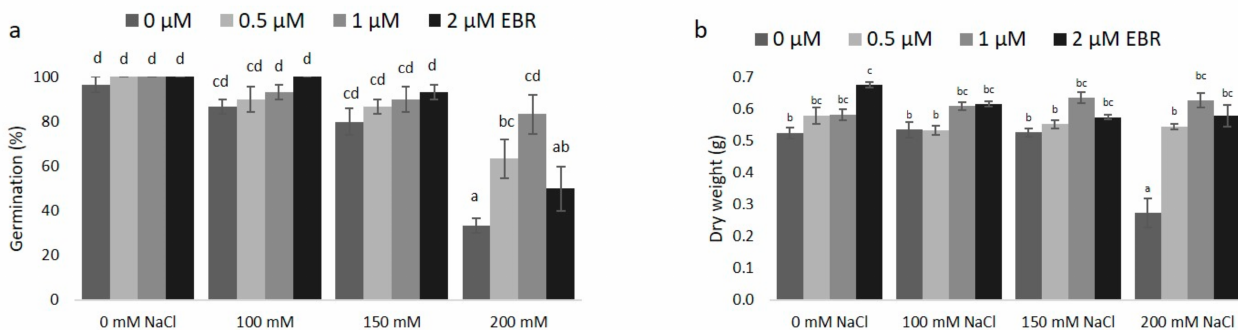
Figure 1. Cotton seed germination and seedling growth under salt stress following pre-treatment with 24-epibrassinolide (EBR). Percent germination ( a ) and seedling dry weight ( b ) in response to 0, 0.5, 1 and 2 µ M concentrations of EBR under 0, 100, 150 and 200 mM NaCl were recorded for seedlings on the 4th and 13th day, respectively. Error bars represent standard error (SE) of the mean for three replicates ( n = 30). Different letters above the bars indicate significant differences in two-way analysis of variance (ANOVA, p < 0.05) followed by Tukey’s post hoc